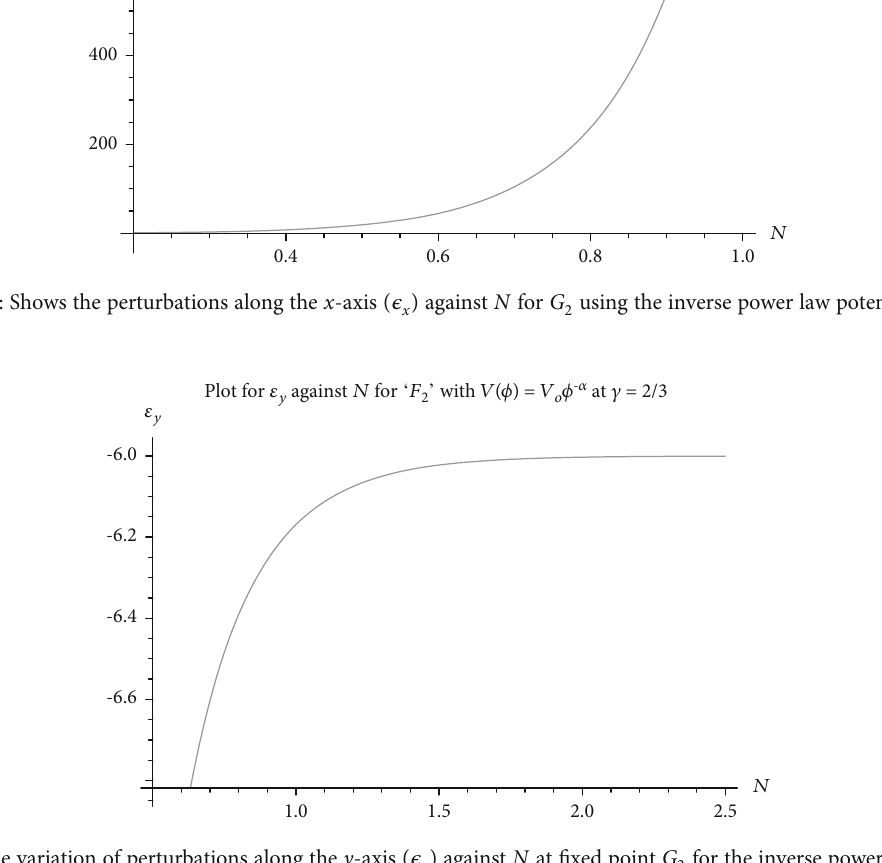
) against N at fi xed point G 2 for the inverse power law potential form. y